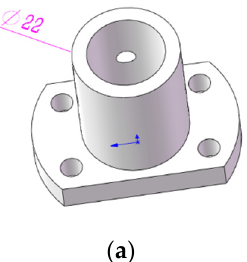
Figure 10. Variation of axis diameter and length of bearings with different guiding shafts.